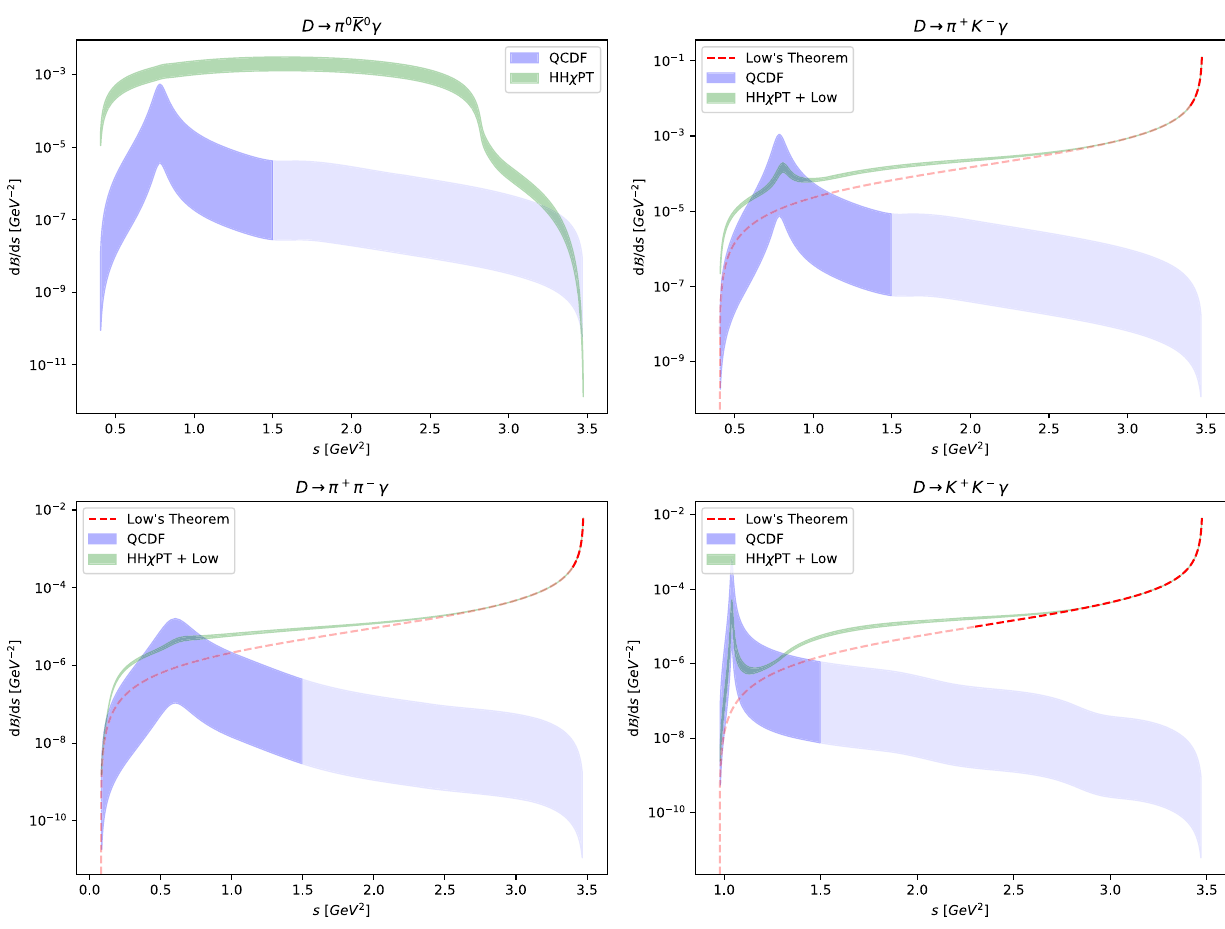
Fig. 3 The SM predictions for the differential branching ratios of the decays D → K 0 π 0 γ (upper left), D → K − π + γ (upper right), D → π + π − γ (lower left) and D → K + K − γ (lower right). Blue bands correspond to QCDF, green bands to HH χ PT and the red dashed